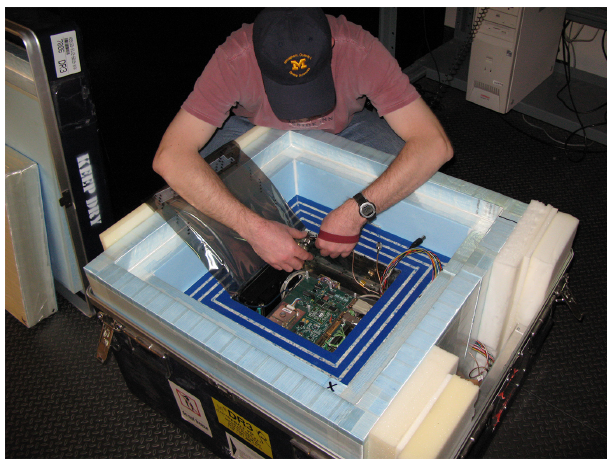
Figure 5. The super-insulated electronics